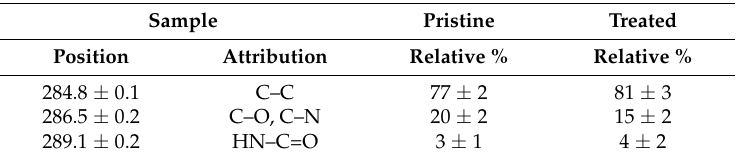
Figure 4. C1s XP-HRR of pristine leatherette ( a ) and treated leatherette ( b ).